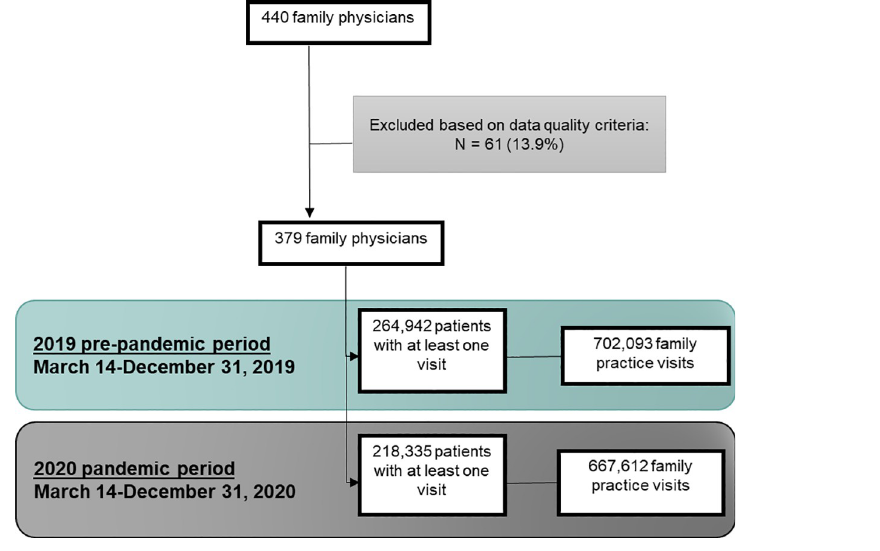
Fig 1. Record selection